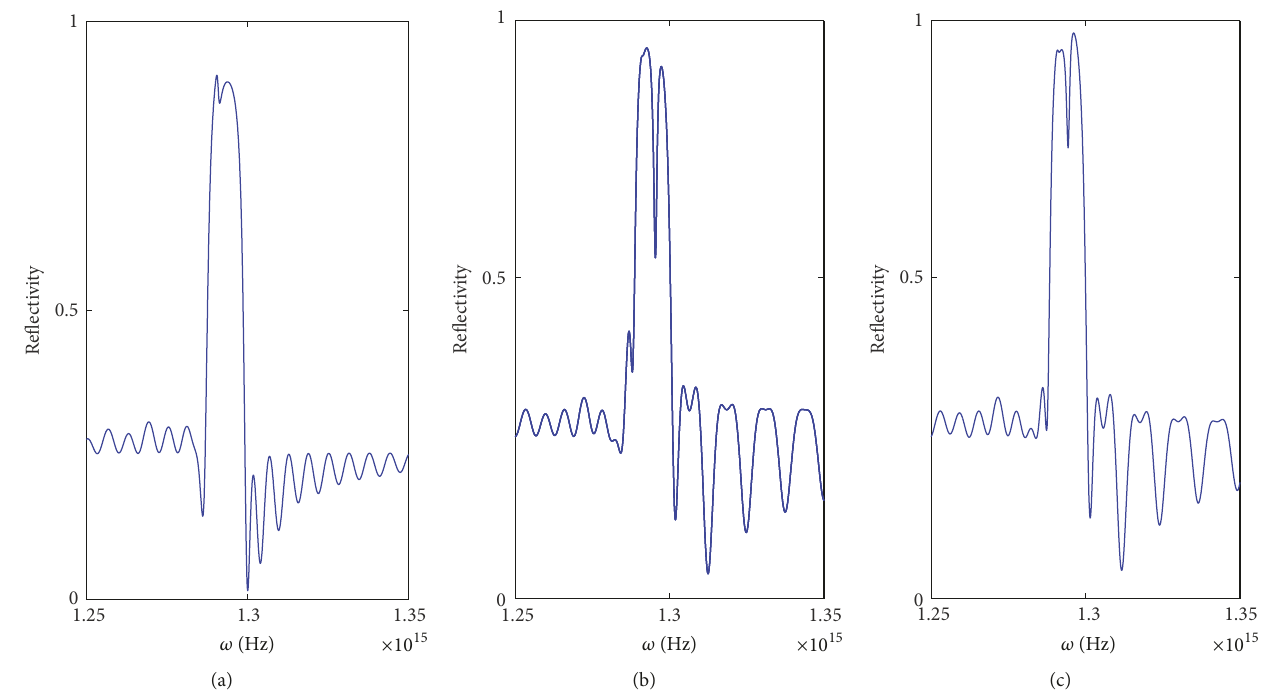
Figure 9: Reflectivity spectra of InGaAs/InP QMW (a) without any defect, (b) with inserting a glass layer as a defect with refractive index 𝑛 = 1.6 and thickness of 𝑑 = 13.16 nm, and (c) with doubling the width of the central 𝑔 𝑔